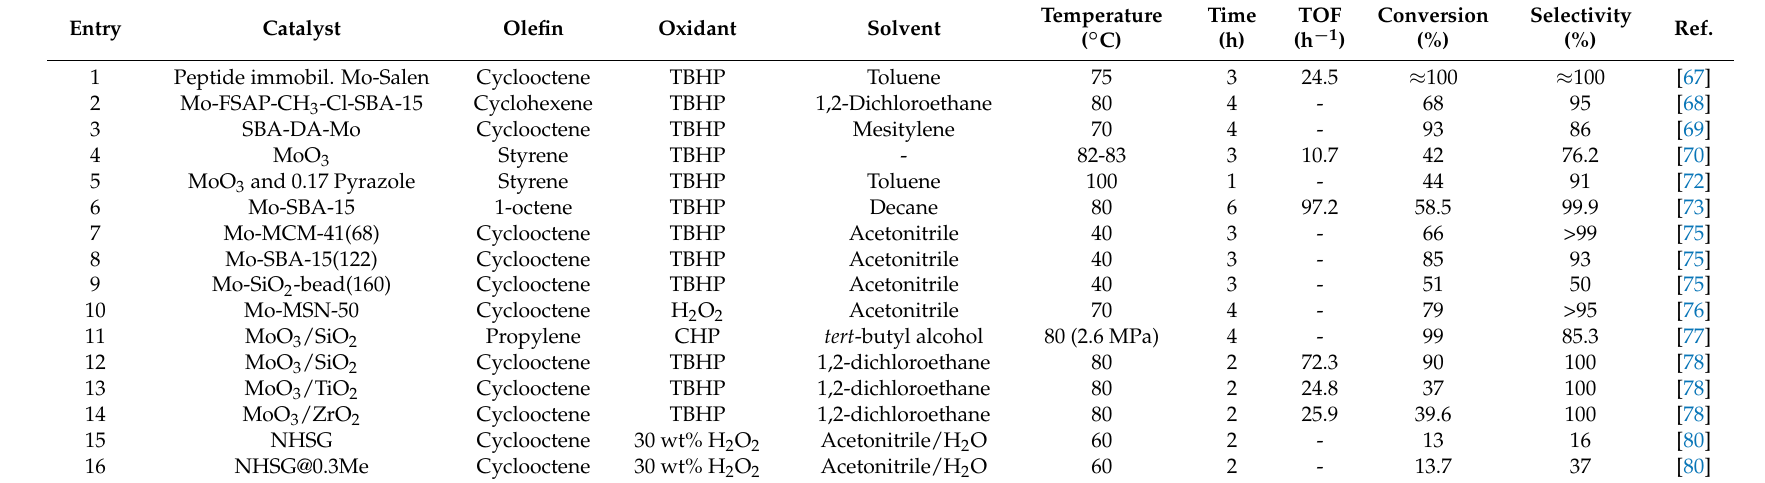
Table 3. Results of epoxidation reactions by using various silica supported molybdenum-based